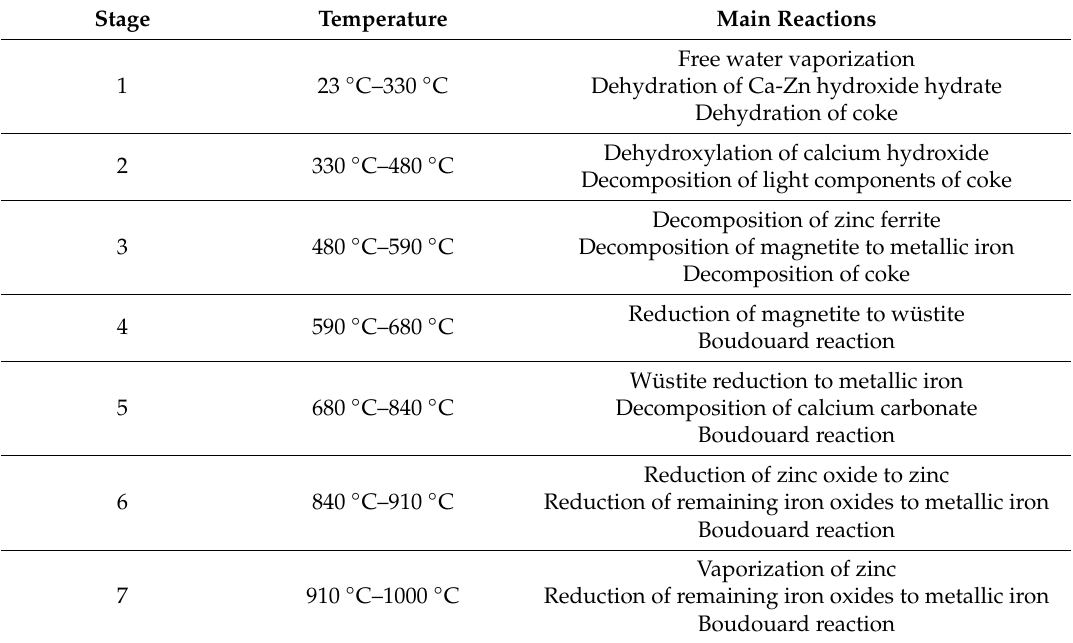
Table 3. Main identified stages during microwave carbothermic